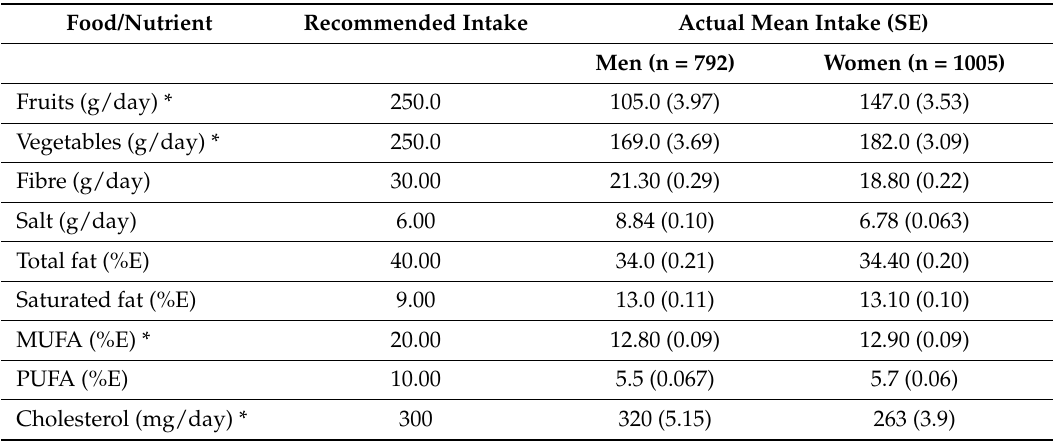
Table 1. Mean dietary component intake versus recommended intake for Swedish men and women.